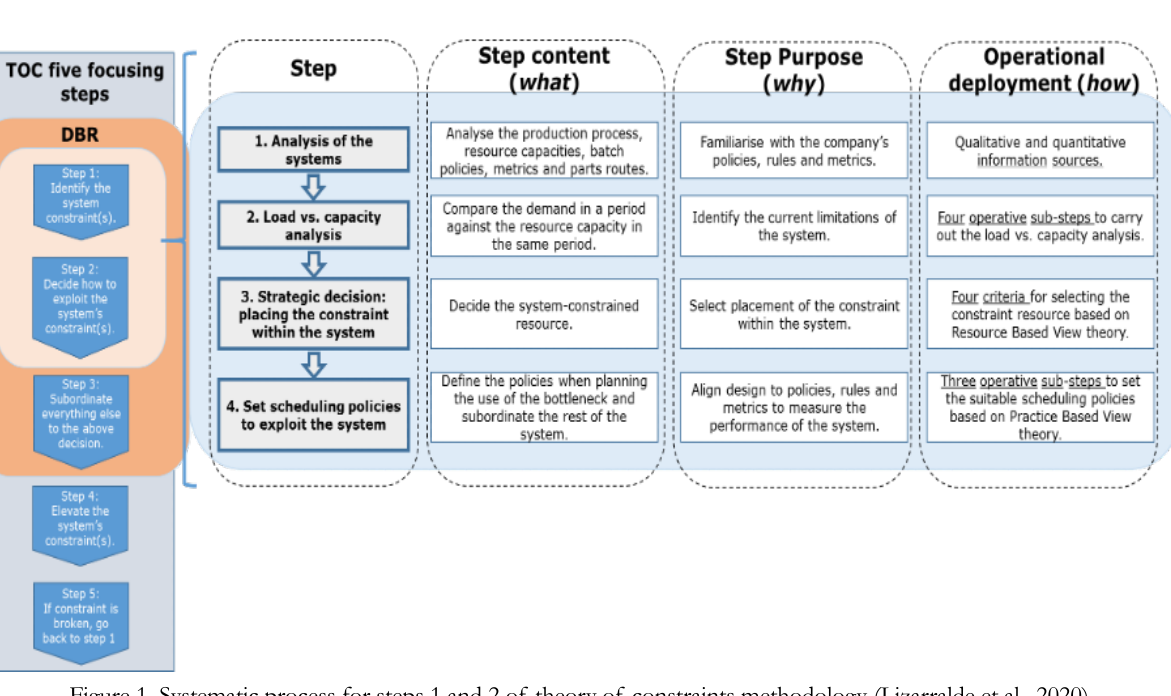
Figure 1. Systematic process for steps 1 and 2 of theory of constraints methodology (Lizarralde et al.,